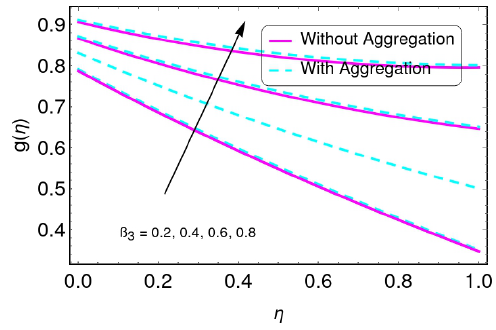
Figure 12. The results of ß 3 on g ( η ) .